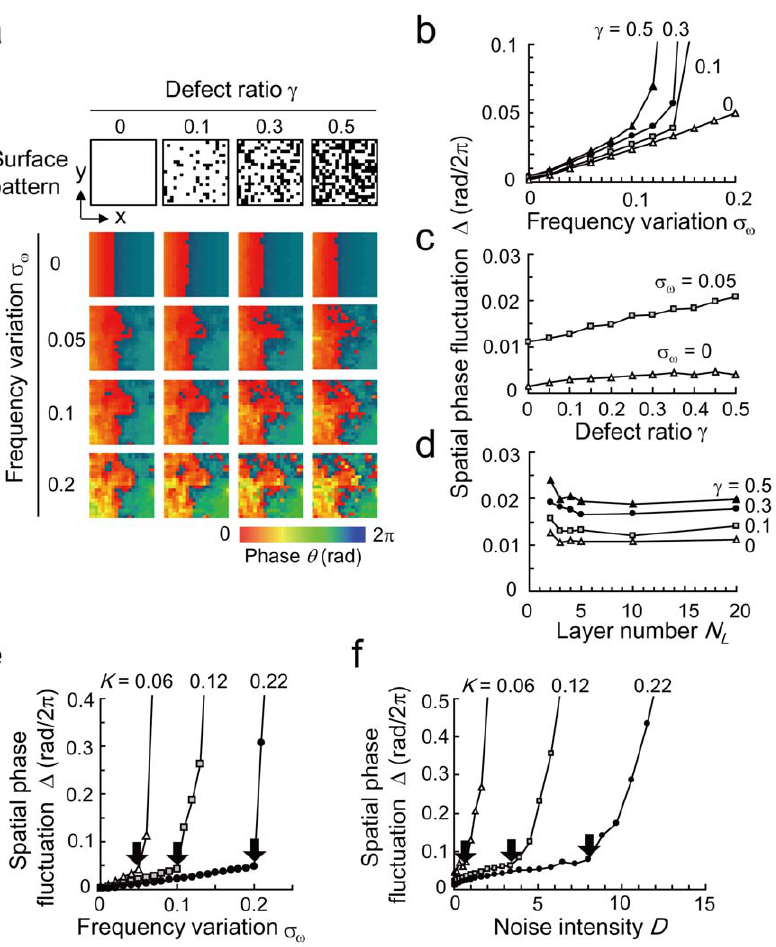
Figure 4. Spatial fluctuation and robustness of the SCN networks. (a) Dependence of the spatial phase fluctuation D on the standard deviation of the natural frequencies s v and the defect ratio c . Coupling strength and number of the layers were set to K =0.22, N L =10. The color map is the same as in Fig. 2a. (b) Dependence of D on s v for c =0, 0.1, 0.3, 0.5. K =0.22, N L =10. (c) Dependence of D on c for s v =0, 0.05. K =0.22, N L =10. (d) Dependence of D on N L for c =0, 0.1, 0.3, 0.5. s v =0.05, c =0.5, K =0.22. (e) Dependence of D on s v for K =0.06, 0.12, 0.22. N L =10, c =0, D =0. (f) Dependence of D on the dynamical noise intensity D for K =0.06, 0.12, 0.22. N L =10, c =0, s v =0.05. Robust synchronization was observed up to the critical points indicated by the black arrows in (e,